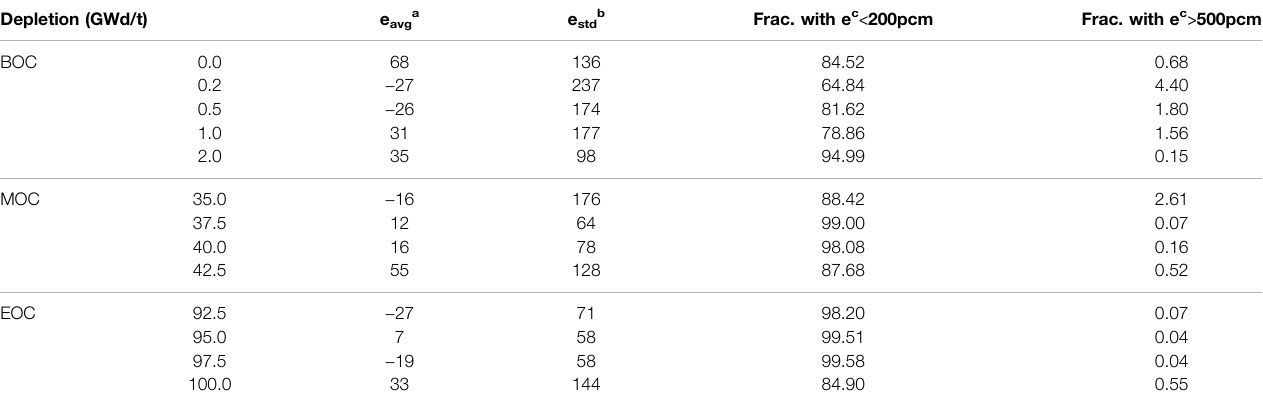
TABLE 3 | Eigenvalue prediction error of trained